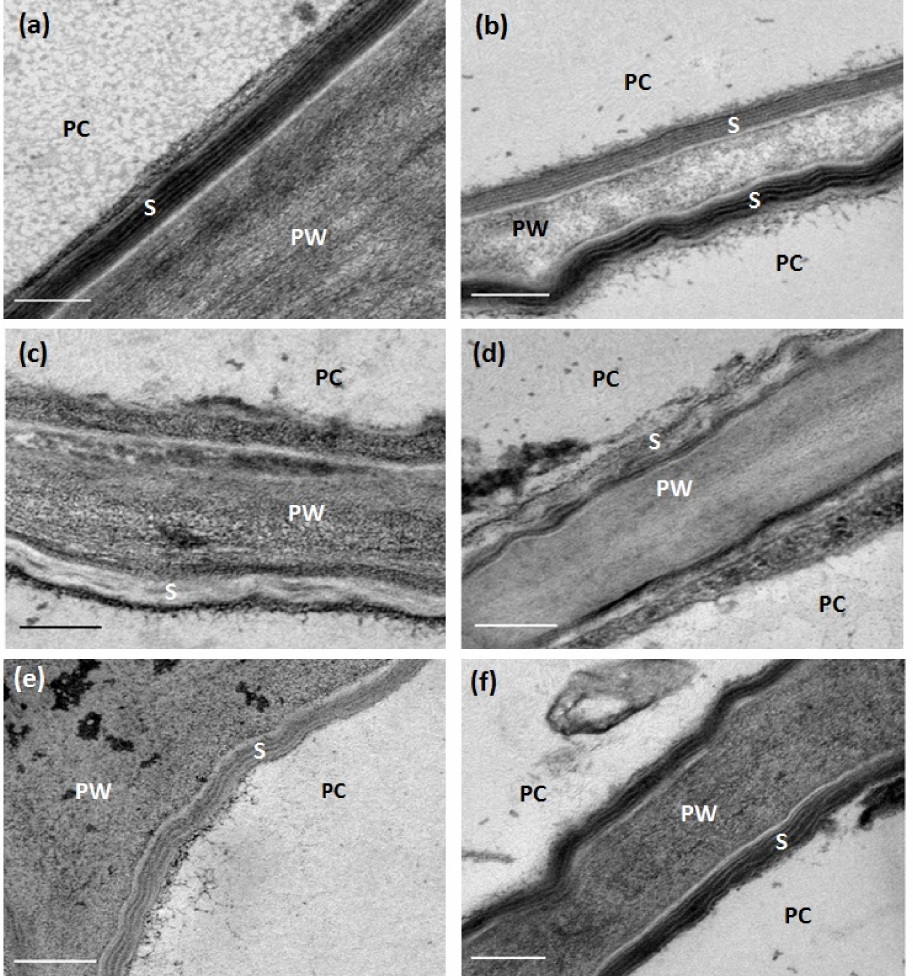
Figure 5. Transmission electron microscope images of A. thaliana root sections of the wild type and mutants showing suberin lamellae in the root periderm. Sections were taken from tap roots of 4-week-old wild-type, cyp86a1-1 cyp86b1-1 , and myb92-1 myb93-1 plants grown under control and drought-stress conditions. ( a ) Wild type, control; ( b ) wild type, drought; ( c ) cyp86a1-1 cyp86b1-1 , control; ( d ) cyp86a1-1 cyp86b1-1 , drought; ( e ) myb92-1 myb93-1 , control; ( f ) myb92-1 myb93-1 , drought. S, suberin lamellae; PW, primary cell wall; PC, periderm cell. Scale bar = 200 nm. 2.5. Suberin Deficiency and Aberrant Lamellae Structure Correlates with Increased Water Loss in Root